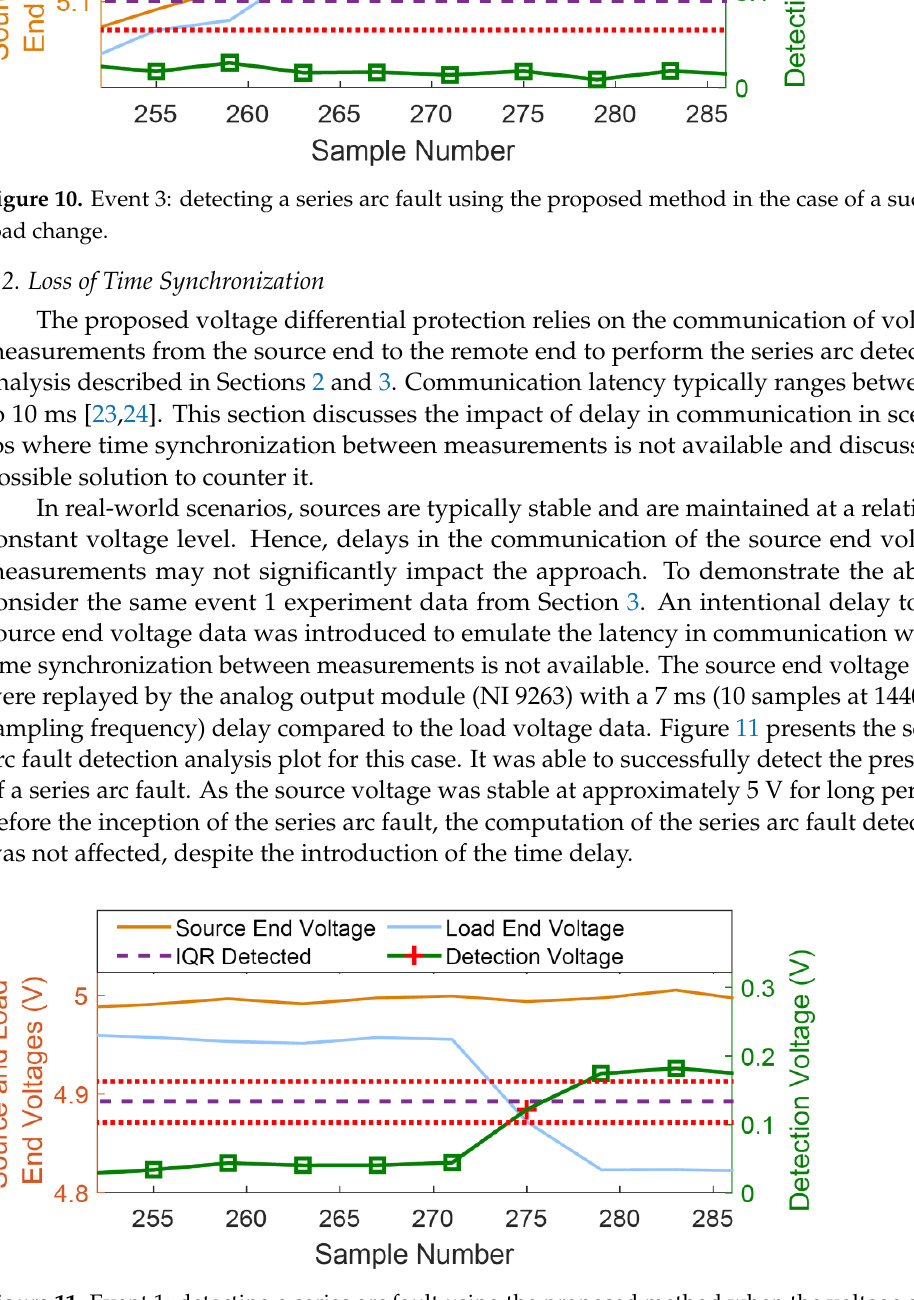
Figure 11. Event 1: detecting a series arc fault using the proposed method when the voltage at the source end is